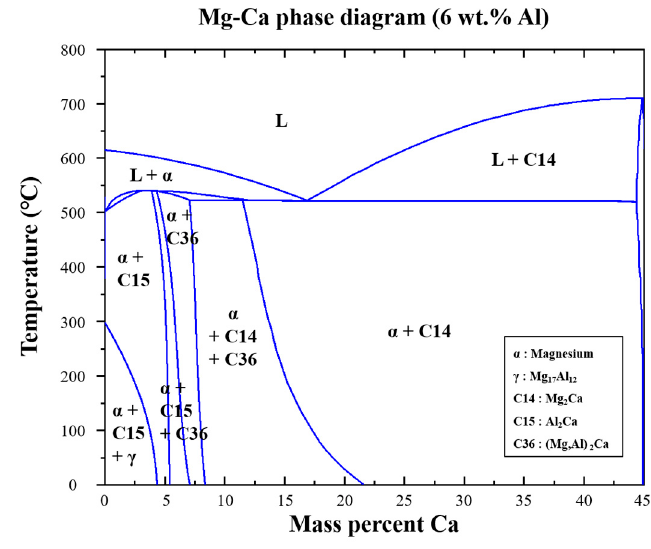
Figure 2. Phase diagram of Mg-Ca binary system at 6 wt.% Al content.